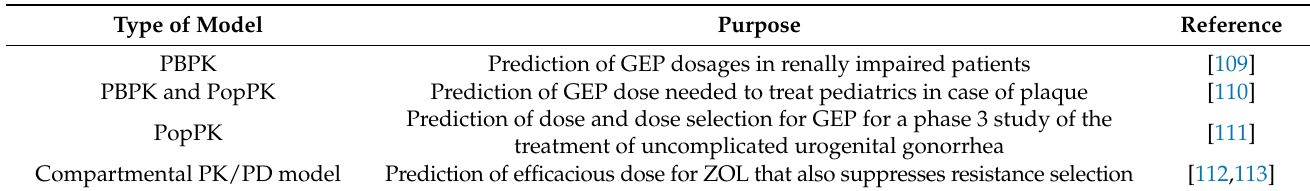
Table 2. PK and PK/PD models used for gepotidacin and